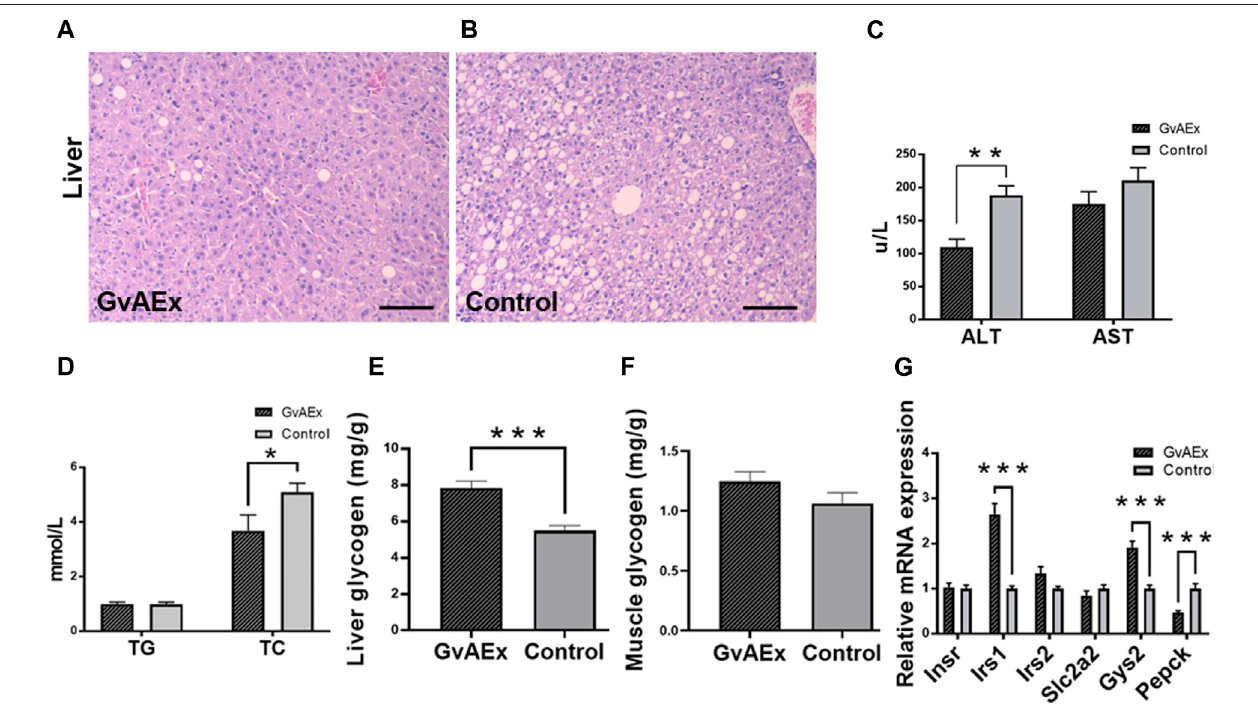
FIGURE 3 | GvAEx treatment promotes liver function and reduces gluconeogenesis. (A,B) Representative light microscopic images of liver in db/db mice treated withGvAEx (A) orvehicle (B) for12 weeks(scalebar=100 μ m). (C) Plasmalevelsofalanineaminotransferase(ALT)andaspartatetransaminase(AST)( n =6/group). (D) Plasma levels of total cholesterol (TC) and triglyceride (TG). (E) Hepatic glycogen content. (F) Skeletal muscle glycogen content ( n = 6/group). (G) Relative mRNA expression levels of genes involved in glycogen synthesis and gluconeogenesis in the liver. * p < 0.05, ** p < 0.01, *** p <